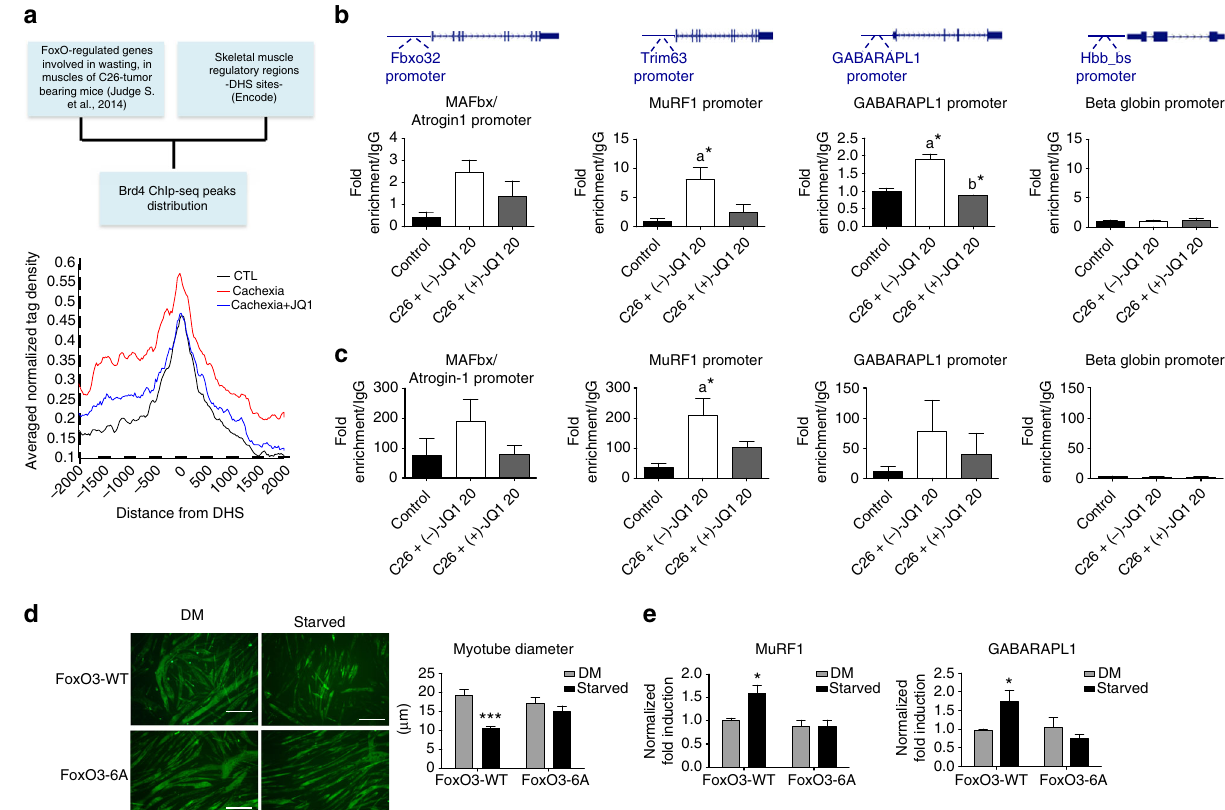
Fig. 7 FoxO3 and AMPK directly associate to catabolic genes promoters in skeletal muscles of cachectic mice. a Left panel: scheme of the bioinformatics analysis used to generate the average pro fi le of BRD4 ChIP-seq tag counts around ± 2 kb of DHSs neighboring a subset of FoxO-regulated genes in control, Cachexia, and Cachexia/JQ1+ mice (right panel). b FoxO3 ChIP qPCR at promoters of muscle catabolic genes and beta globin gene as a negative control. IgG was used as a reference; n = 3. Data represent means ± SEM. Statistical analysis was performed by using one-way ANOVA followed by Tukey ’ s